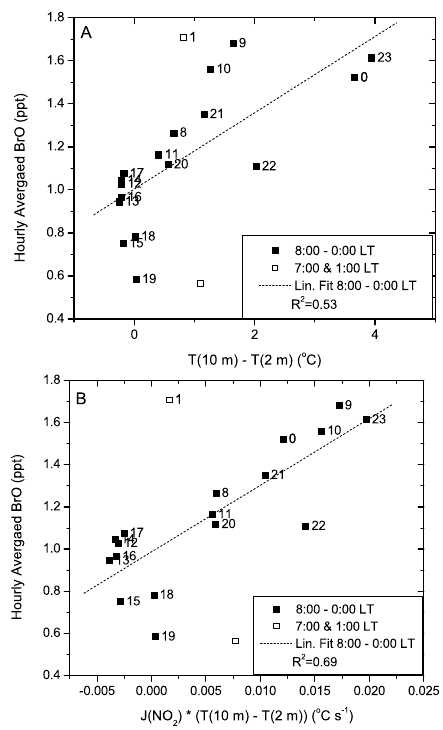
Fig. 7. Correlation of hourly averaged BrO mixing ratios for local air masses during the 2008 experiment with the temperature gradi- ent as a proxy of vertical stability (A) and the product of the tem- perature gradient and the NO 2 photolysis rate J (NO 2 ) (B) . Only data from 08:00LT to 0:00LT is considered in the analysis. The BrO average for 07:00LT and 01:00LT was based on too few data points to be representative and, although shown in the figure, was not included in the correlation analysis. Labels denote the hour of the